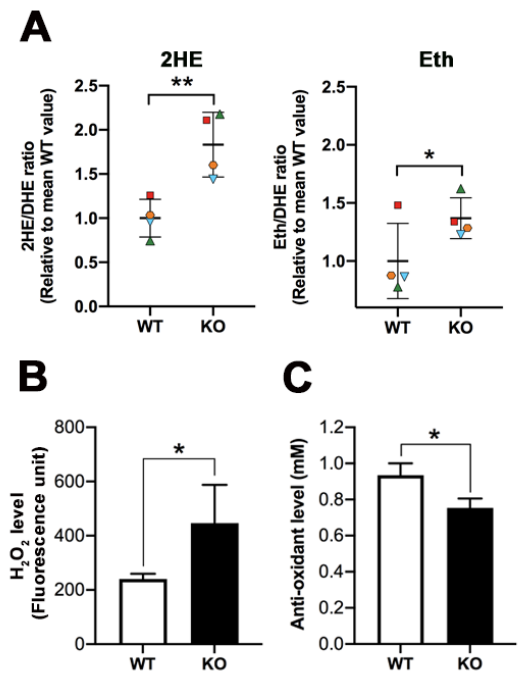
Figure 9. ( A ) . Higher superoxide anion levels (2HE) and other ROS plus oxidants (Eth) in the cauda epididymis of 8-month-old Arsa null mice, compared with age-matched WT mice. Data from the KO mice were expressed as fold increases over the corresponding values from WT mice in a similar manner as described in the Figure 5 legend. Results were from four replicate experiments. Higher amounts of H 2 O 2 ( B ) but lower levels of antioxidants ( C ) in the caudal epididymal fluid of 8-month- old Arsa KO mice, compared with the counterpart fluid of age-matched WT mice were also displayed. Results on both quantifications were from three replicate experiments. *, ** denotes p < 0.05 and 0.001, respectively.